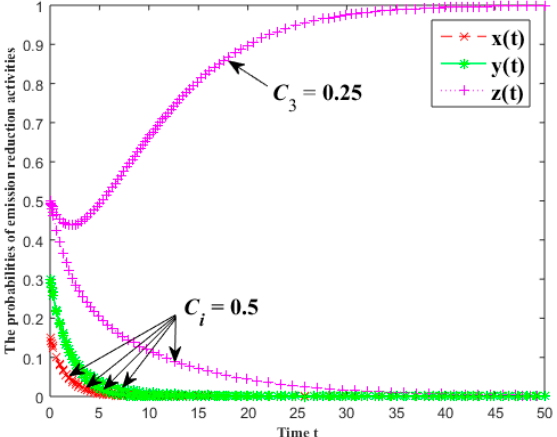
Figure 3. The effects of the input costs of emission reduction on the probabilities of emission reduction activities.